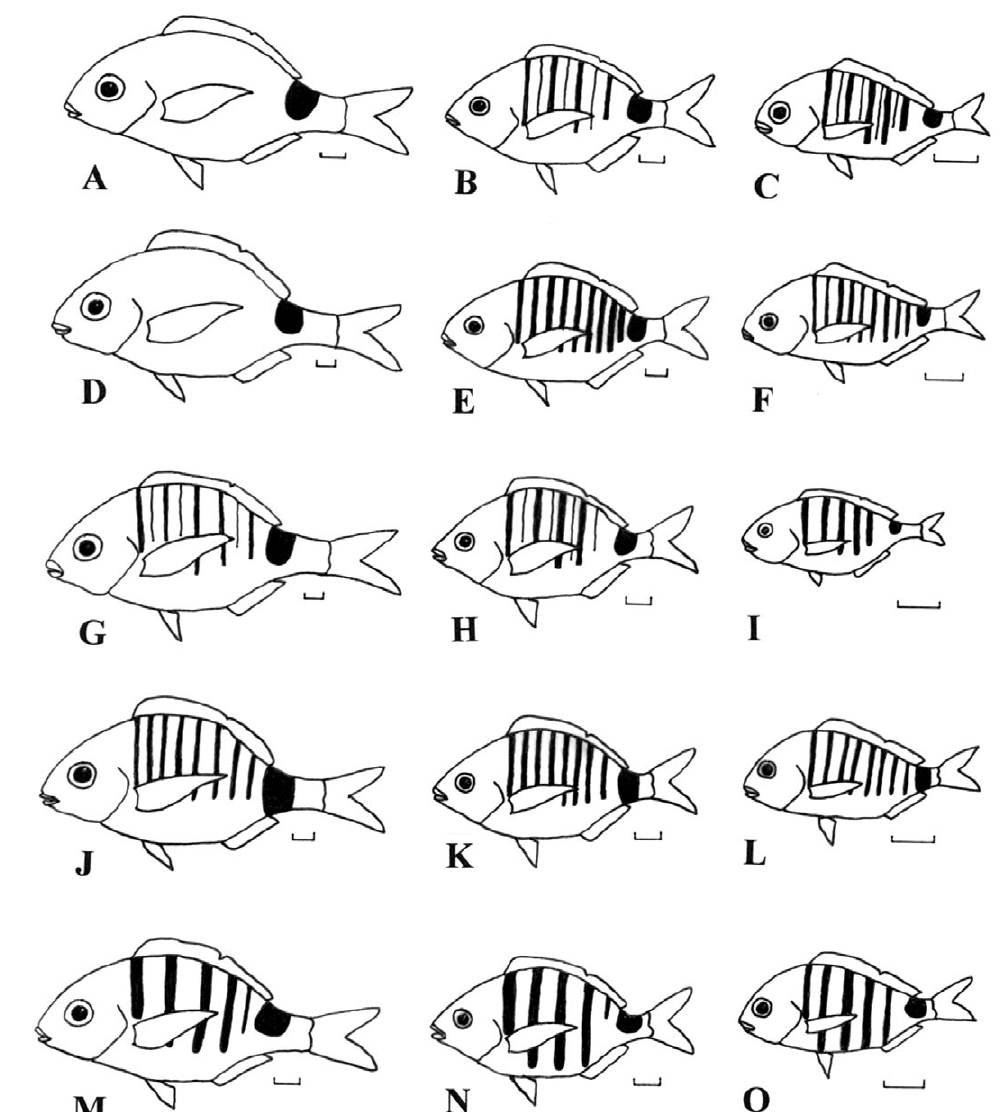
Fig. 7. – Generalised body colour patterns of the species of the Diplodus sargus group; large adults, medium adults and small adults. Diplodus sargus : A , MNHN A-8098 (255 mm SL), France, Marseille; B , MNHN 1961-0894 (192 mm SL), Monaco, 1961. C , MNHN uncat. (92 mm SL), France, Villefranche-sur-Mer. Diplodus capensis : D , MNHN A-8096 (315 mm SL), South Africa, Cape Province. E , MRAC 97894 (215 mm SL), South Africa, Elephant Bay. F , SAIAB 1638 (109 mm SL), South Africa, Cape Province. Diplodus cadenati : G ,